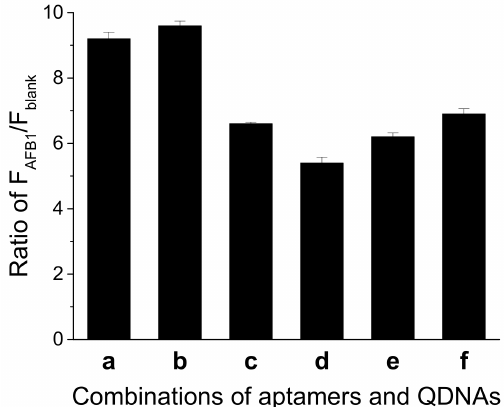
Figure 3. Effects of different combinations of aptamer and QDNA on the ratio of F AFB1 /F blank